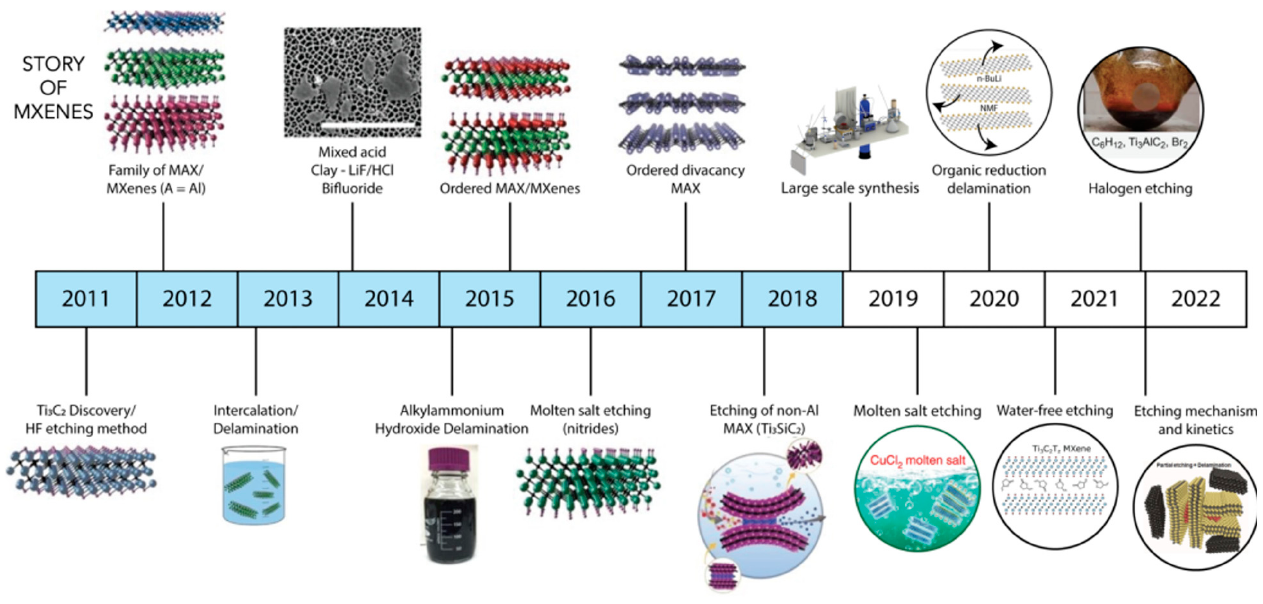
Figure 2. Story of MXenes synthesis concerning year. Reprinted with permission from Ref. [14].